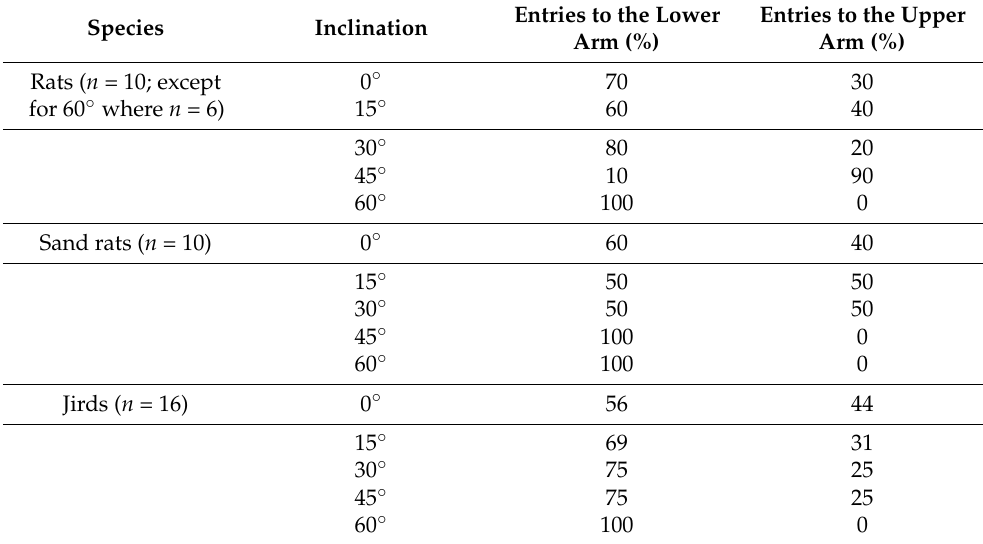
Table 3. The percentage of entries into the lower and upper arm first. Group size is depicted beside each species. The percentage of individuals that progressed to enter the lower or the upper arm first is depicted for each inclination in each species. Note that the group of jirds was larger than those of rats and sand rats.